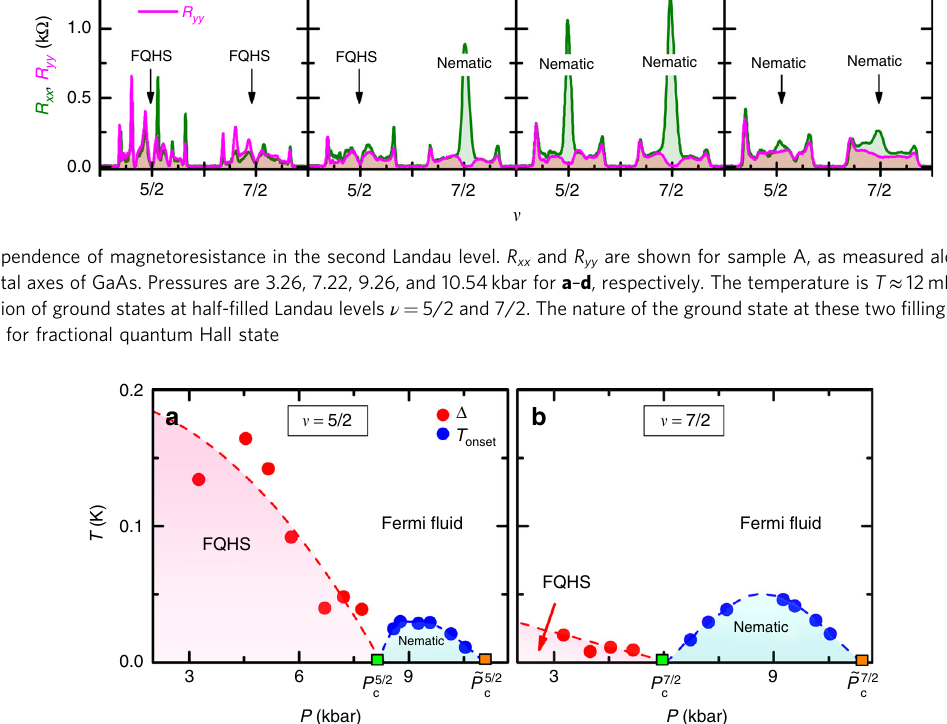
Fig. 3 Stability diagrams in the half- fi lled second Landau level. The stability diagrams for sample A are obtained from plotting the energy gap Δ of the FQHS and the onset temperature T onset of the nematic. Analysis is done at ν = 5/2 ( a ) and ν = 7/2 ( b ). The energy gap decreases with increasing pressure, while the onset temperature of the nematic exhibits a dome-like shape. Green squares represent the quantum critical point of the paired-to-nematic and orange squares of the nematic-to-Fermi fl uid transition. Lines are guides to the